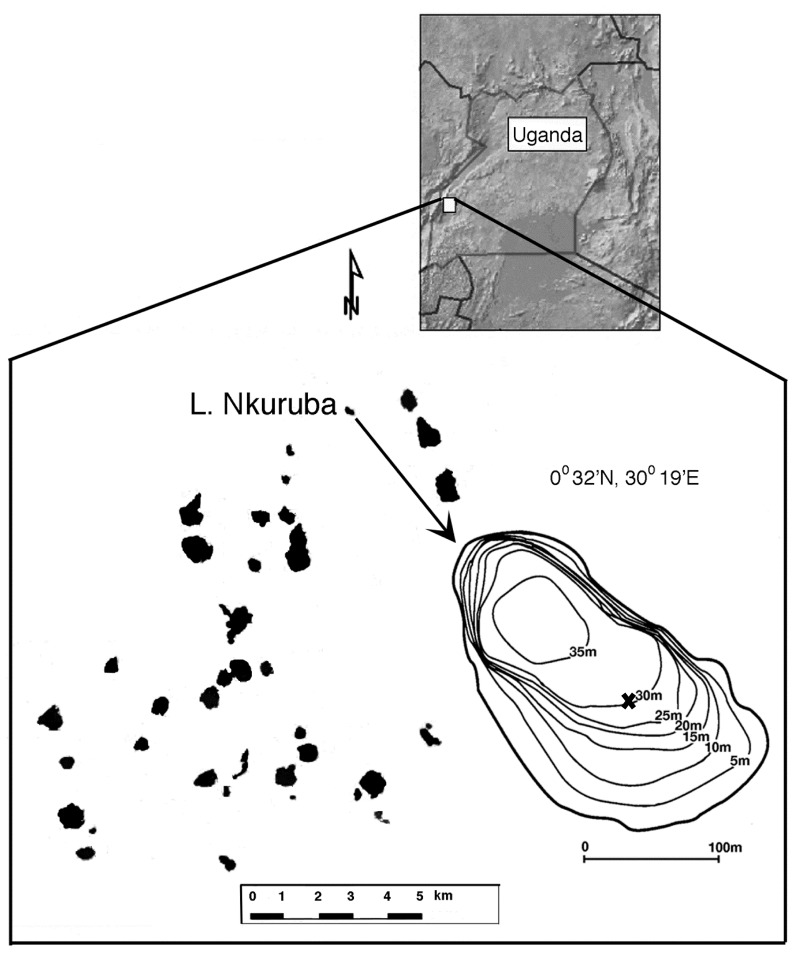
Map showing location of the study lake among other crater lakes of the Kabarole, Uganda region.The X marks the coring site and contour lines represent bathymetry (modified from [15]).